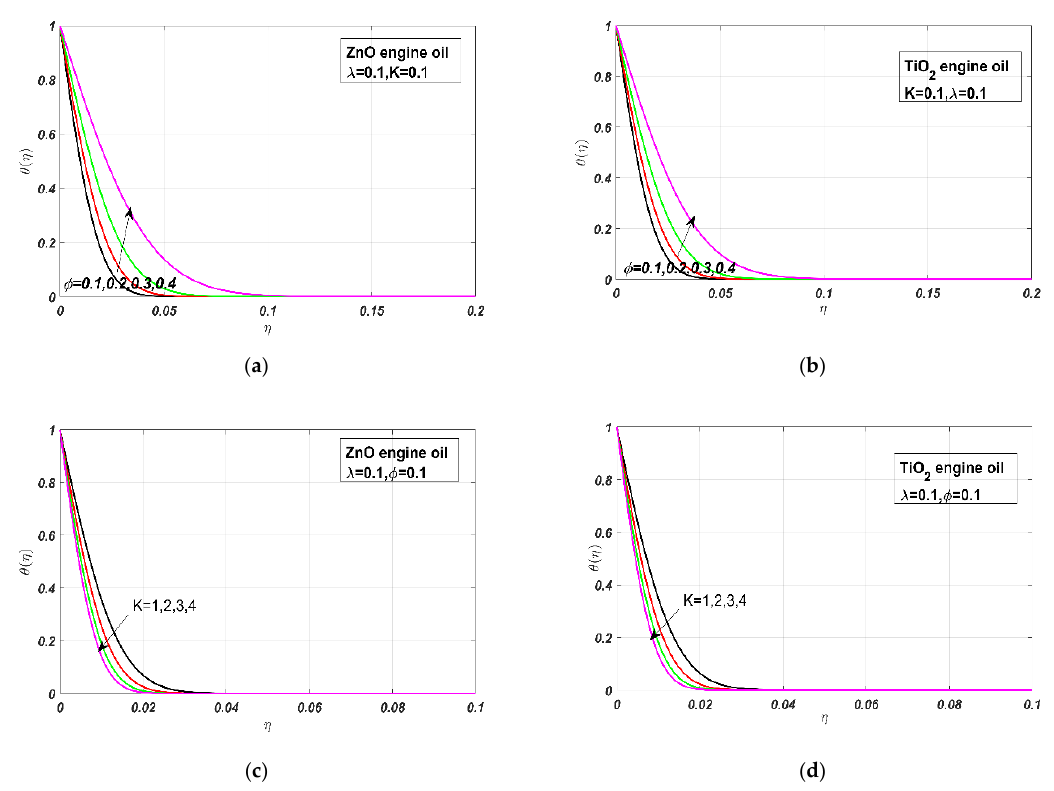
Figure 5. The impact of volume fraction ϕ ( a , b ) and slip parameter K ( c , d ) on the temperature profile f ( η ) for ZnO and TiO 2 engine oil nanofluids.